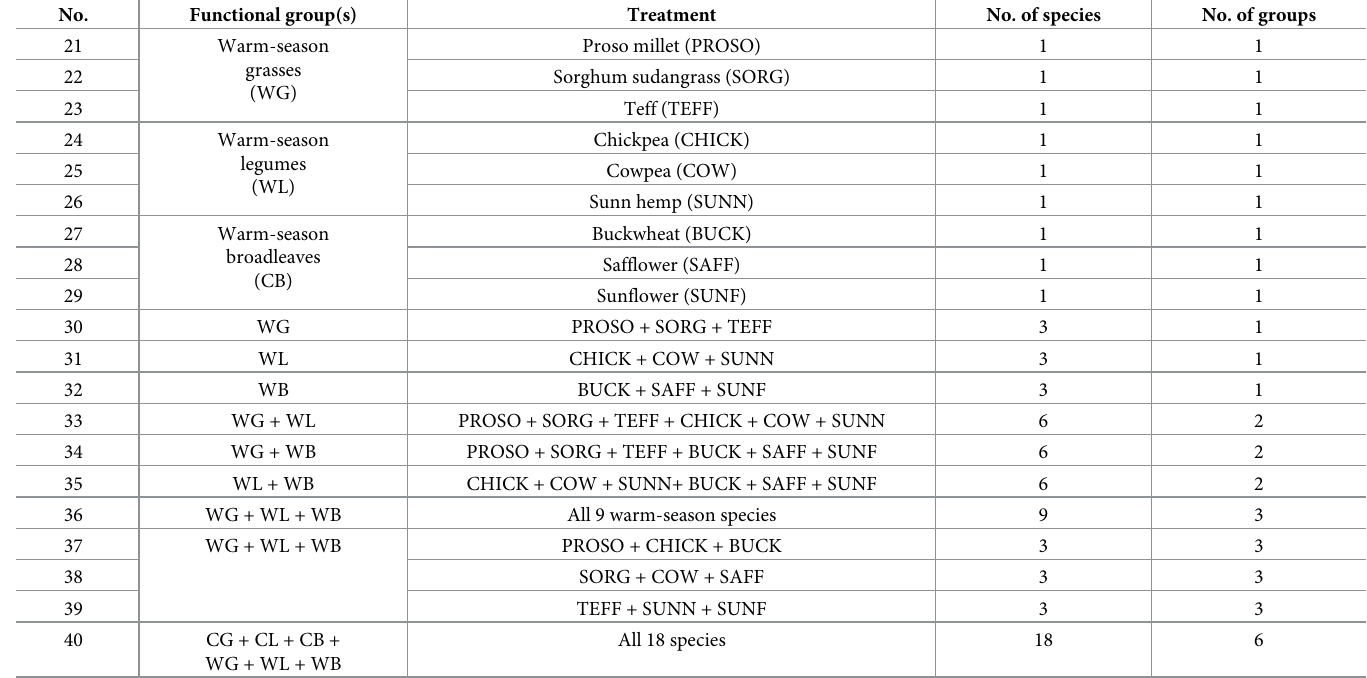
Table 3. Summary of cover crop treatments added in